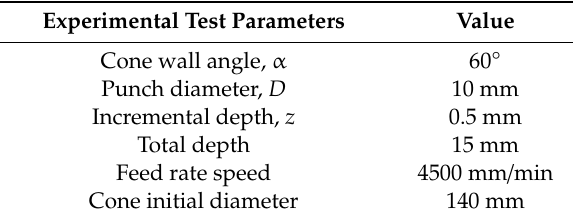
Table 4. Process parameters used in the experimental